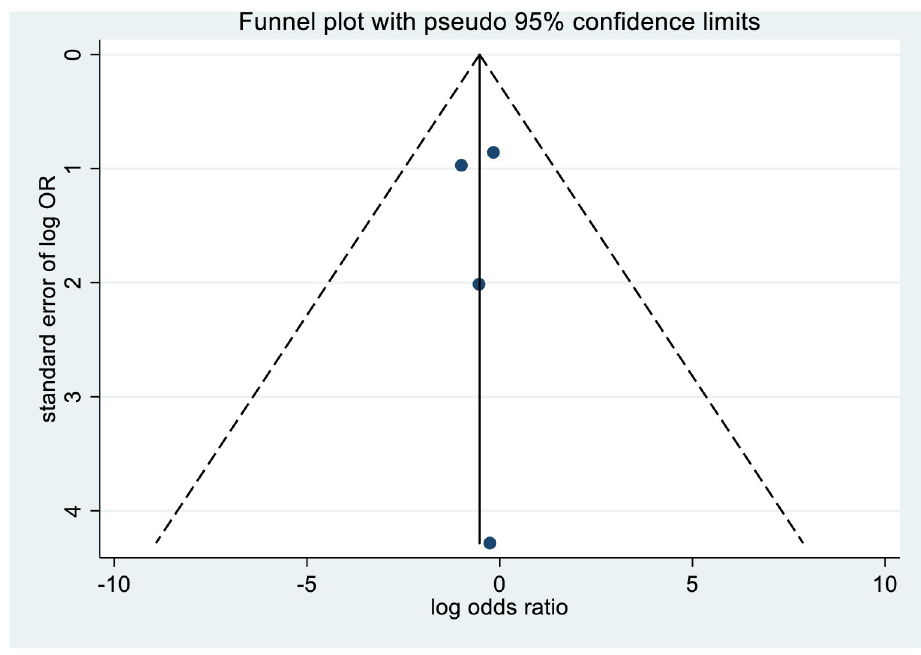
Fig 3. Funnel plot of the association between the DPP-4i use and the mortality of COVID-19. https://doi.org/10.1371/journal.pone.0251916.g003 alone, DPP-4is combined with insulin effectively control blood glucose levels, and their effec- tiveness and safety are guaranteed [19, 20]; additionally, good glucose control can improve the prognosis and outcome of COVID-19 [21]. Therefore, the use of DPP-4is may also exert a ben- eficial effect on controlling glucose homeostasis in patients with COVID-19 and diabetes.